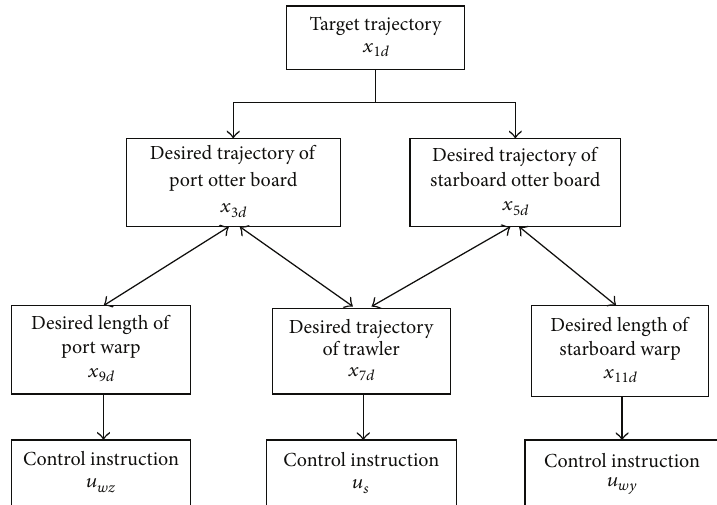
Figure 3: Physical connection of key state